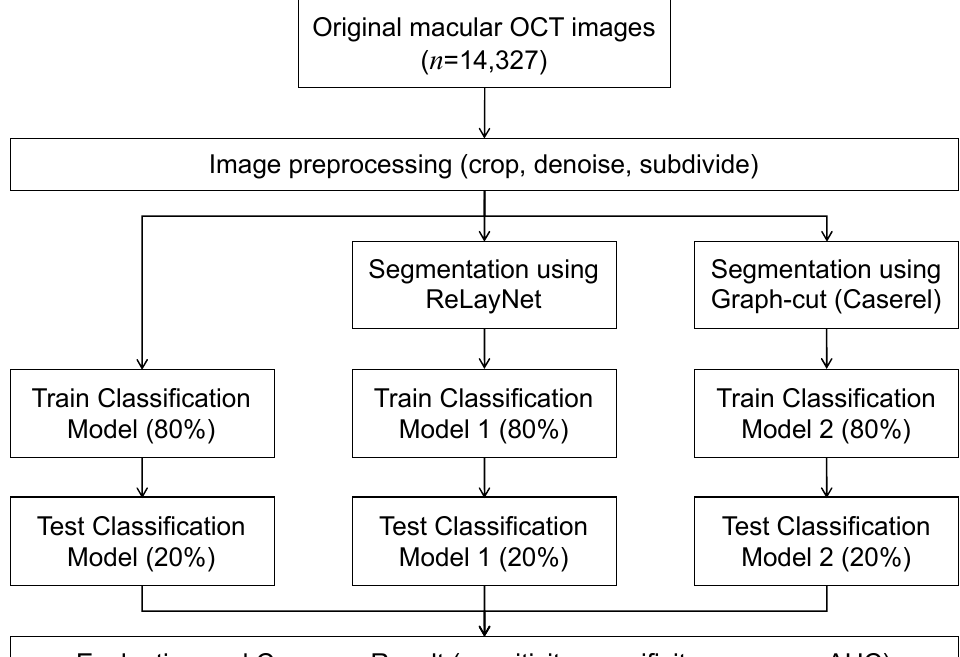
Figure 1. Workflow diagram.